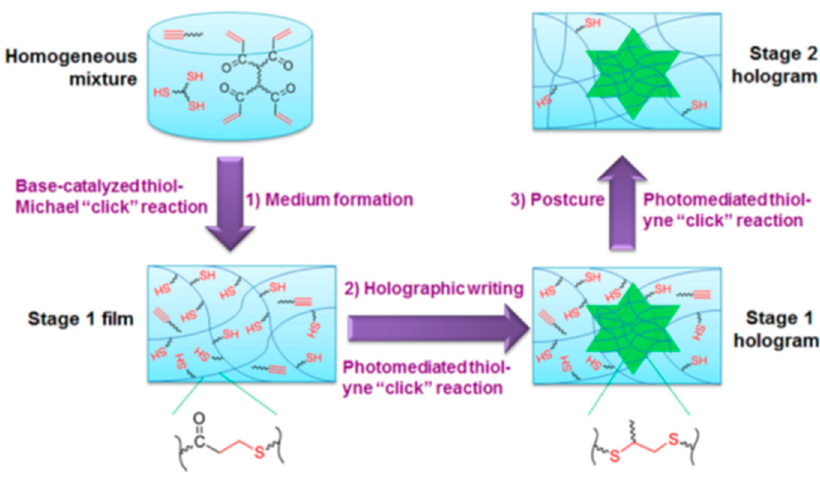
Figure 7. A thiol-acrylate-yne ternary system for holographic patterning. Reproduced with permission from [195]. Copyright: 2014, American Chemical Society.